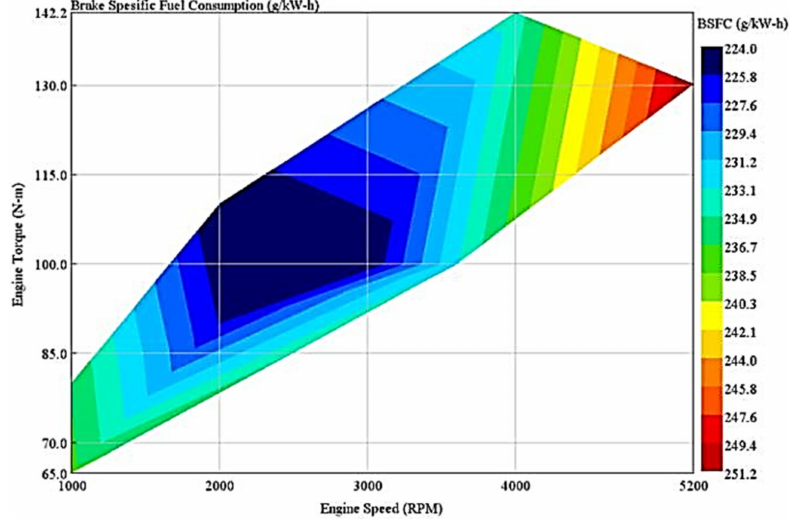
Figure 12. BSFC from Engine